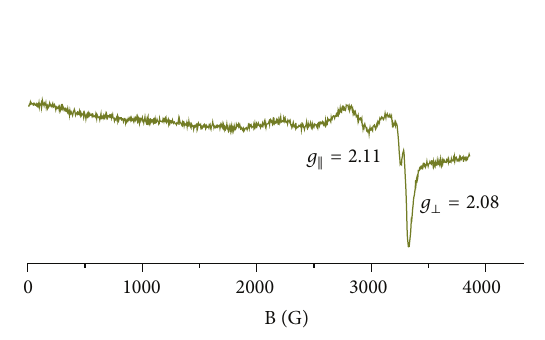
Figure 13: EPR spectrum for [Cu 2 Ni( S,S (+)cpse) 3 (H 2 O) 3 ] ⋅ 9H 2 O ( 2 ).